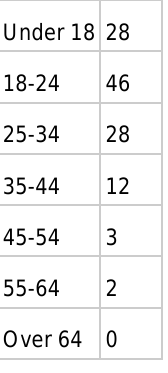
Table 2 . Gender distribution ( s urvey)